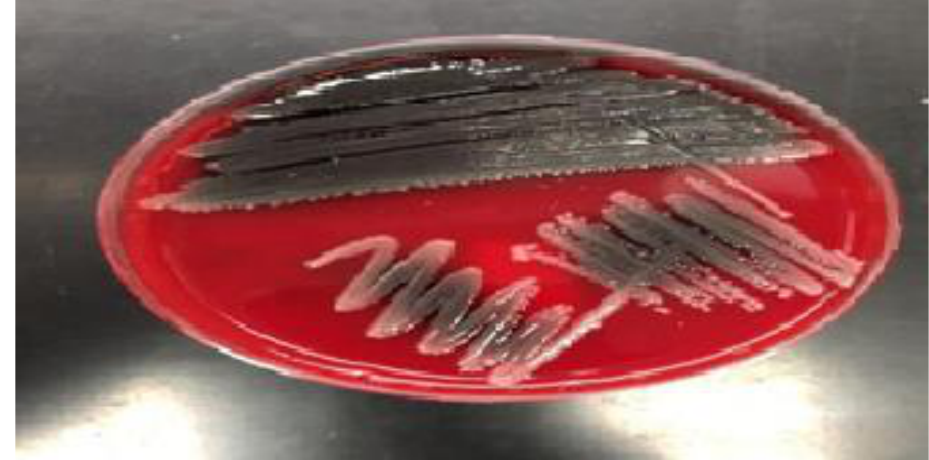
Figure 4. A plate of blood agar showing growth of P. aeruginosa .